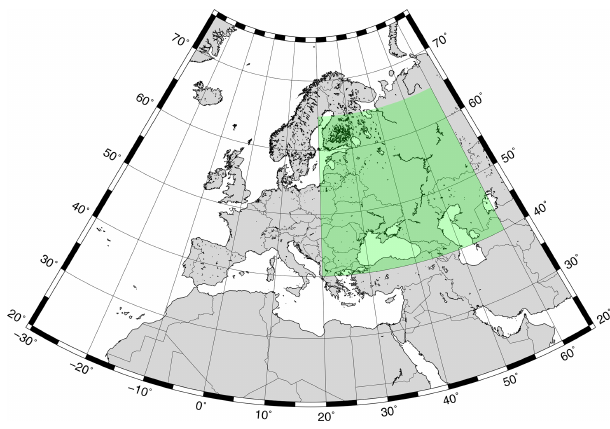
Figure 1. Simulated domain (grey) and fire-affected target area (green box).